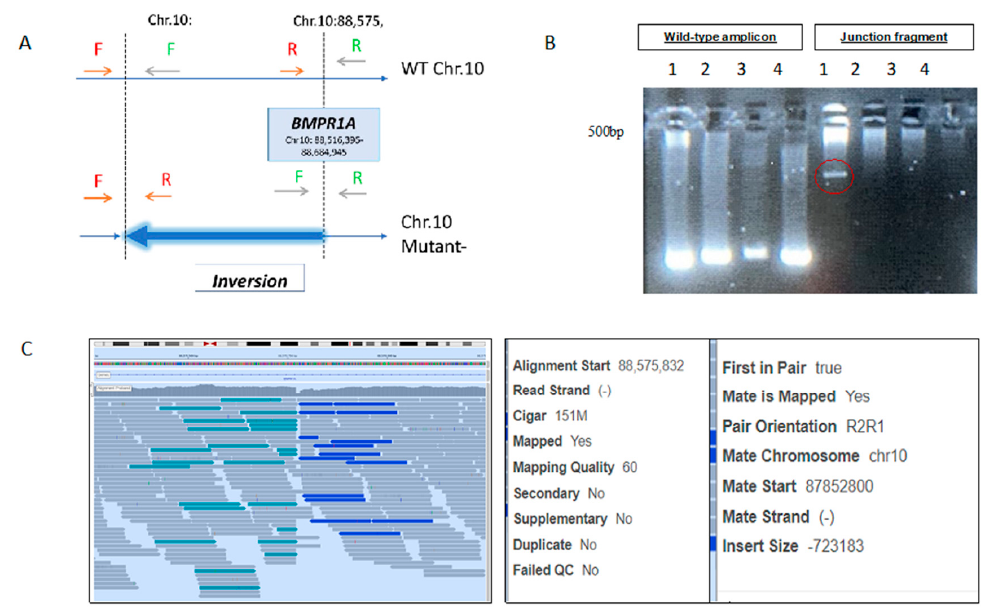
Figure 1. ( A ) Schematic analysis of BMPR1A inversion: In the wild-type state, chr.10 cannot be am- plified by the combination of F up and R up or F down and R down primers, due to the distance between them and their orientation. The dashed lines indicate the break points of the inversion. In affected individuals, both primer pairs are in proximity and alignment that allow the amplification of the inversion junction fragment and, as a result, the detection of ~200 bp PCR products (bold arrow). ( B ) Sample 1 represents the affected proband, while the other 3 samples are of healthy con- trols. The normal region of the gene-wild-type amplicon is demonstrated in all DNA samples, while it is amplified in the proband. However, the junction fragment that represents the mutant allele was amplified only in the proband that carries the BMPR1A inversion (enhanced by a red circle). ( C ) IGV snapshot of the BMPR1A breakpoint of the identified inversion and an example of a read pair in which both reads have the highest mapping quality, yet the first is at position 88.5 M and the second is mapped to 87.8 M on the same chromosome and on the opposite strand (both mapped minus, while usually strands of paired reads should be opposite). Segregation analysis (Figure 2) for BMPR1A-linked haplotypes was based on 17 in- formative polymorphic markers, 5 of which are localized within the inverted region. The other 12 are flanking the BMPR1A gene.